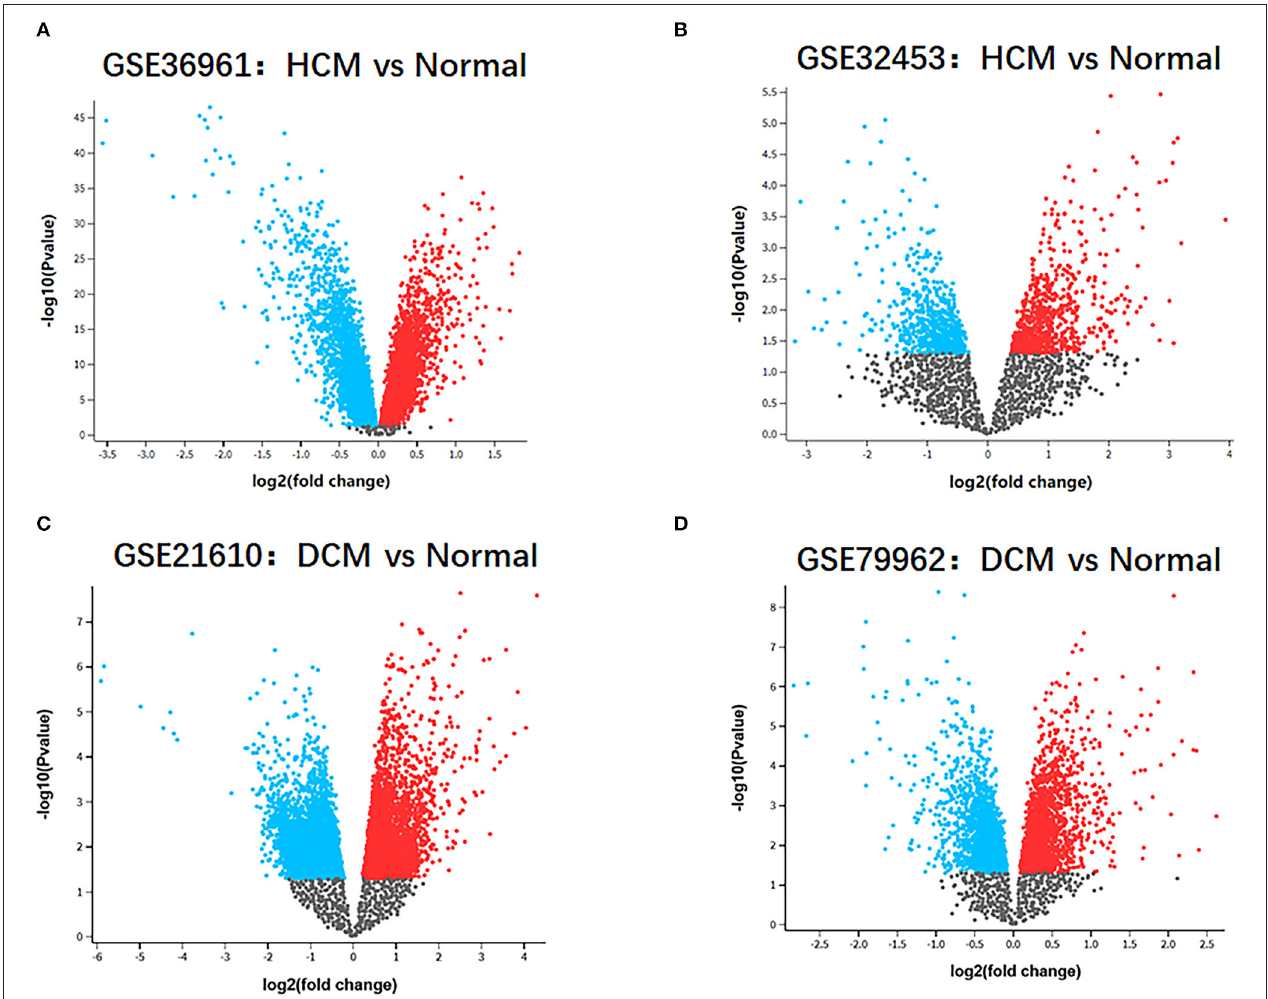
FIGURE 2 | Identification of gene-expression profiles in the 4 datasets. (A) Volcano plot of GSE36961 microarray data. (B) Volcano plot of GSE32453 microarray data. (C) Volcano plot of GSE21610 microarray data. (D) Volcano plot of GSE79962 microarray